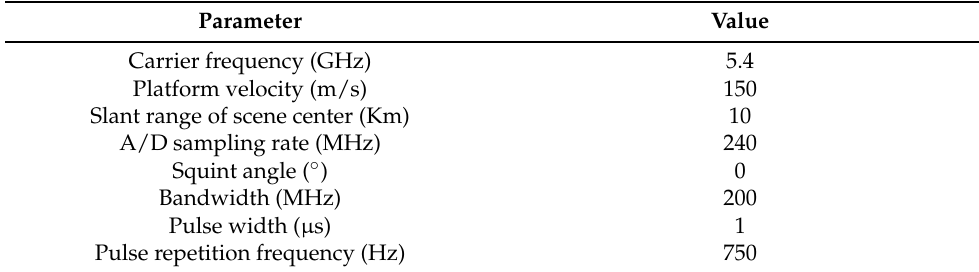
Figure 5. Ship model. Table 1. The system parameters of the simulation